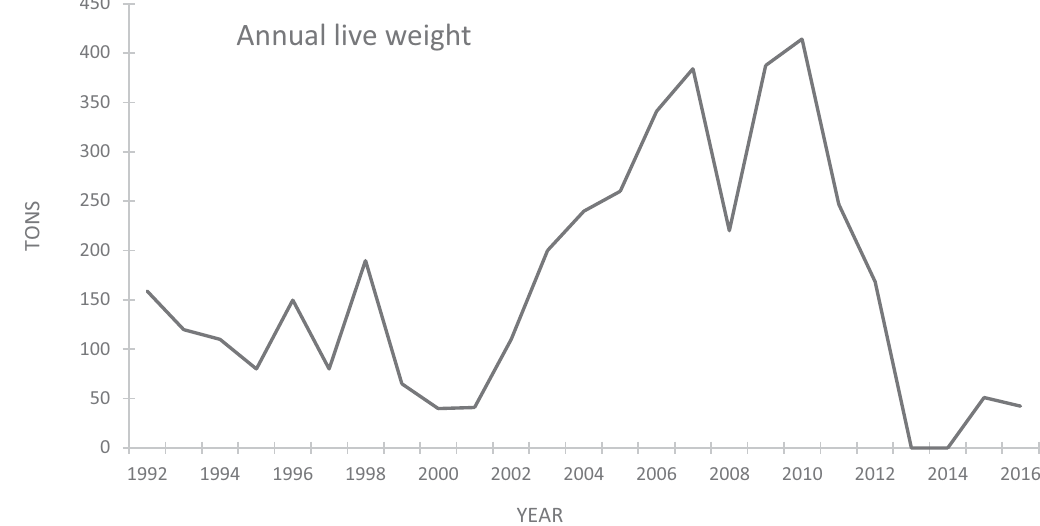
Fig. 1. Reported Pomacea patula catemacensis live weight catch from 1992 to 2016 (CONAPESCA, 2017). There was no reported catch for 2013 and